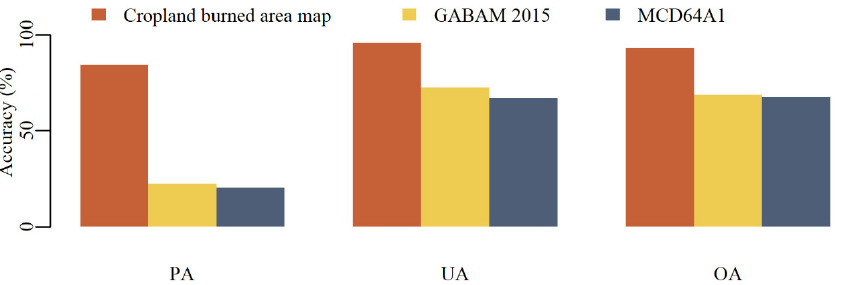
Figure 8. The producer’s accuracy (PA), user’s accuracy (UA), and overall accuracy (OA) for the burned area type in our cropland burned area result, GABAM 2015 product and MCD64A1